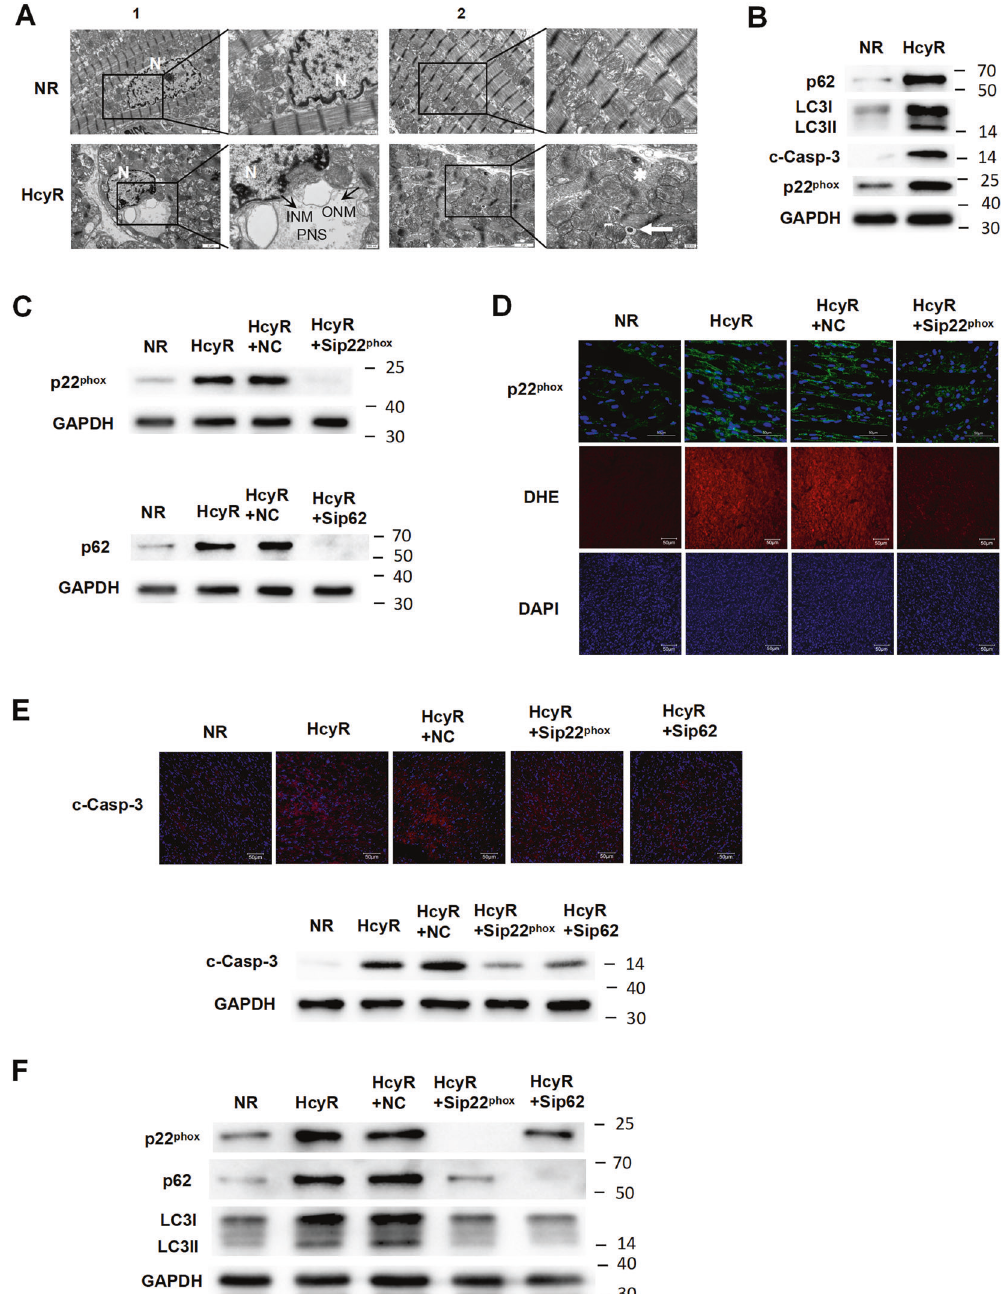
Fig. 5 Activation of the NOX – p62-signaling pathway induces autophagy and apoptosis in the heart of hyperhomocysteinemic rats. A Ultrastructure of the heart from NR and HcyR. The representative transmission electron microscopic (TEM) images of nuclear [1] and other regions [2] of the left ventricles from NR and HcyR are shown. Right panels of image 1 and 2: Details of the swollen perinuclear space (PNS), inner nuclear membrane (INM, black arrow), outer nuclear membrane (ONM, black arrow), autophagosomes (white arrow) and lysosomes (white star). N nucleus. B Expression of LC3, p62, cleaved caspase-3 (c-Casp-3), and p22 phox in the heart of HcyR and NR. The representative western blot results are shown, with GAPDH expression as an internal control. C Expression of p22 phox or p62 in the heart of HcyR with sip22 phox or sip62 administration. The representative western blot results are shown, with GAPDH expression as an internal control. D The representative image of p22 phox or dihydroethidium (DHE) staining of the heart of HcyR with Sip22 phox administration. E Effect of injection of NC, sip22 phox , or sip62 on the expression of cleaved caspase-3 (c-Casp-3) in the heart of HcyR. The upper panel is the representative image of the cleaved caspase-3 (c-Casp-3) staining, and the lower panel is the representative western blot results, with GAPDH expression as an internal control. F Effect of injection of NC, sip22 phox , or sip62 on the expression of p22 phox , p62, and LC3. n = 7 rats/group. NR normal rat, HcyR homocysteinemic rat, HcyR + NC homocysteinemic rat treated with non-targeting control siRNA, HcyR + Sip22 phox homocysteinemic rat treated with p22 phox siRNA, HcyR + Sip62 homocysteinemic rat treated with p62 siRNA, c-Casp-3 cleaved Caspase-3.